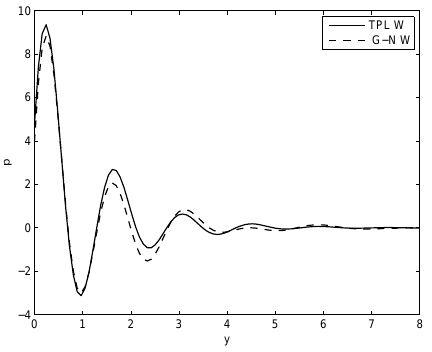
Fig. 5 Distribution the chemical potential p with and without diffusion.